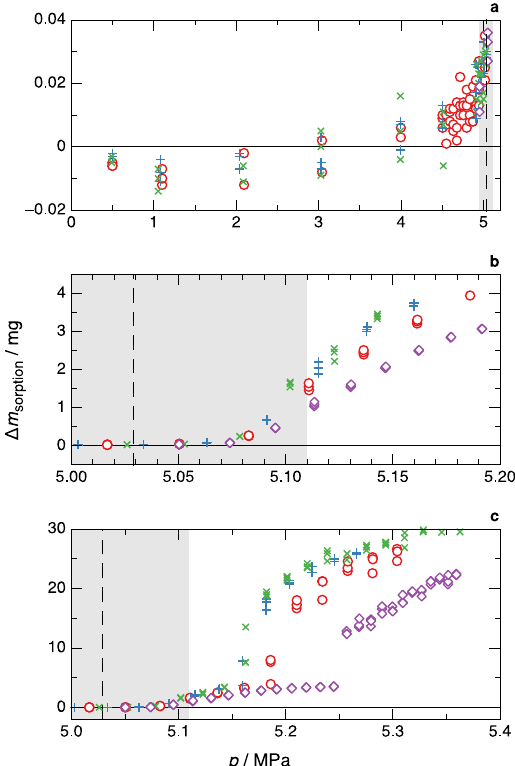
Figure 5. Sorption data for different initial conditions. + , brief purge; × , brief purge (replicate test); ⚪ , 16 h evacuation; ◇ , 234 h evacuation. The mixture is 0.50 CO 2 + 0.50 Ar at T = 253.15 K; plotted are the values of Δ m sorption versus the pressure of the fluid sample; ( a ) vapour (Region I); ( b ) the Region I/II transition and Region II; ( c ) Region III; the vertical dashed line indicates the dew-point pressure calculated by the EOS-CG model of Gernert and Span 12 , and the shaded area is the uncertainty in the EOS-CG